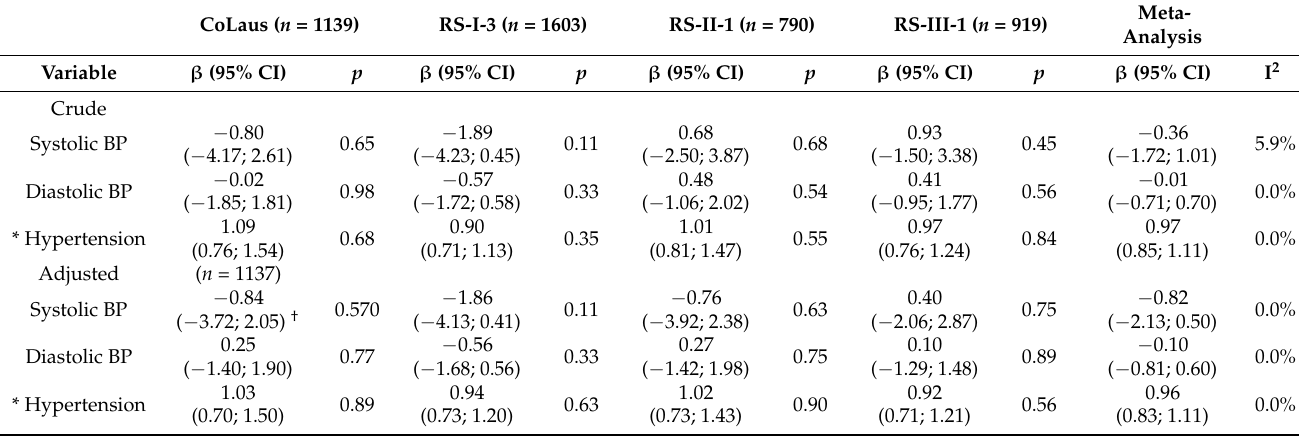
n = number of participants; Adjusted = Fully adjusted model: adjusted for antihypertensive medication; body mass index, drinking status, diabetes, history of cardiovascular diseases, total cholesterol, smoking status, statin use, hormone therapy, education level. β estimates; CI = confidence interval; p = p -value * Odds ratio † 1137